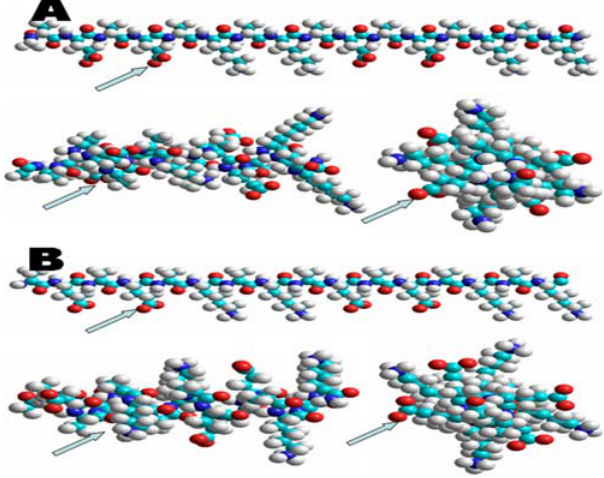
Figure 1. Molecular models of d-EAK16 and l-EAK16. They are a pair of chiral molecules with 3-D mirror image to each other. A) d-EAK16 and B) l-EAK16 are in the extended beta-strand (N– . C) (an alanine at N- terminus is on left and to a lysine at C-terminus on the right). The alpha- helical model, horizontal (left) and alpha-helical model looks from the center of axis (right) (alanine on N-terminus is on top and lysine on C- terminus on the bottom). Color code: hydrogen=white, carbon=cyan, oxygen=red and nitrogen=Blue.